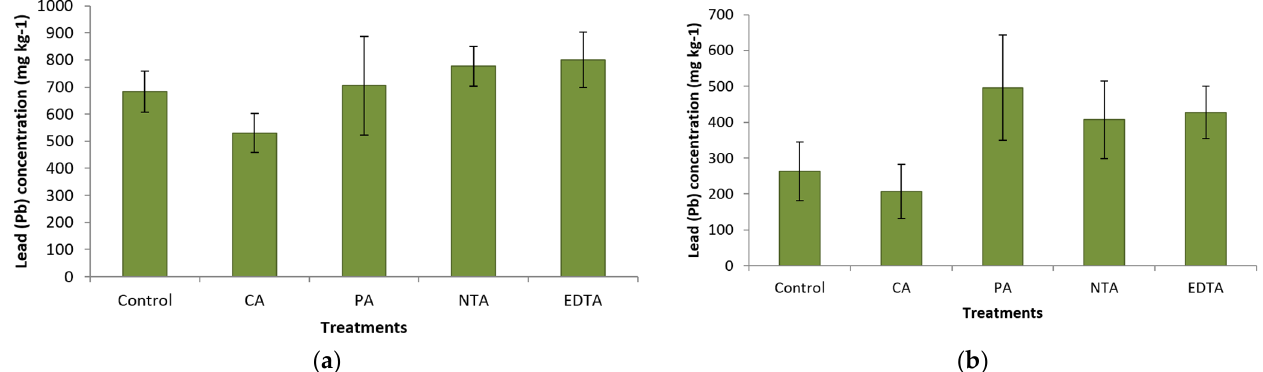
Figure 2. ( a ) Average (+/ − SD) Pb concentration (mg kg − 1 ) of soil wash with 0.05 M acidic acid glacial. (Treatments labeled: CA, Citric Acid; PA, Phytic Acid; NTA and EDTA). ( b ). Average (+/- SD) Pb concentration (mg kg − 1 ) of soil wash with 0.01 M acidic acid glacial. (Treatments labeled: CA, Citric Acid; PA, Phytic Acid; NTA and EDTA).